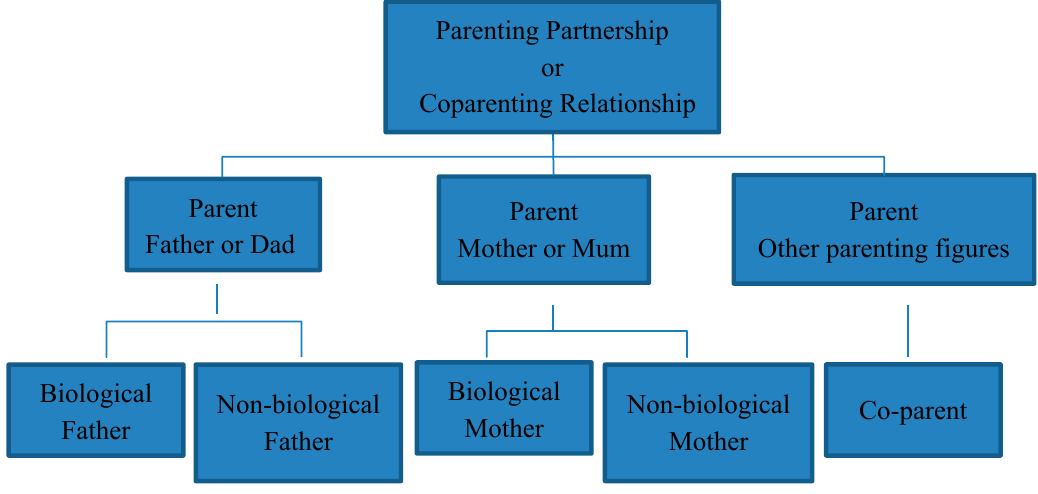
Figure 3. A proposed taxonomy of parent terminology.